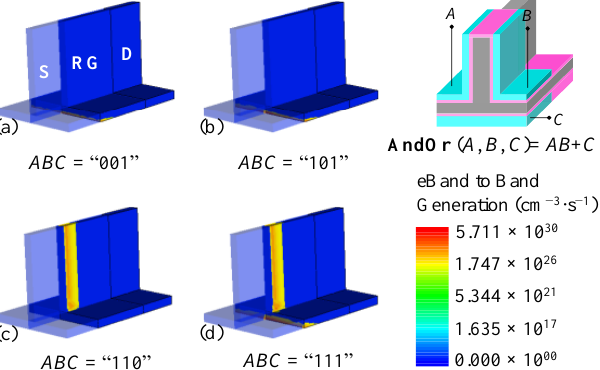
Figure 11. Contour plot of the BTBT generation rate for different gate inputs in AndOr logic device. ( a ) ABC = “001”, ( b ) ABC = “101”, ( c ) ABC = “110”, and ( d ) ABC = “111”. The I D - V BG and I D - V LG characteristics of the N-type (dotted lines) and P-type (dashed lines) device are shown in Figure 12. For the P-type AndOr device, the φ of the left and right gates are both set to 4.22 eV and 5.1 eV for the bottom